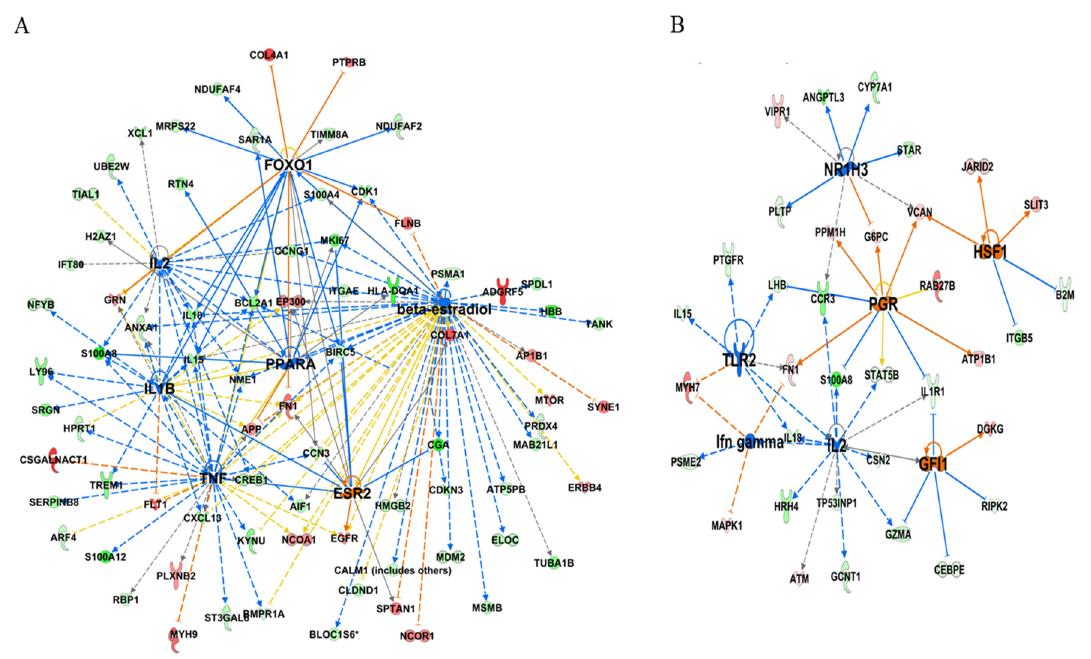
Figure 4. Networks generated for identified upstream regulators of DEGs in porcine endometrium on ( A ) Day 6 of pregnancy or ( B ) Day 6 after SP infusion. Red and green colors depict an increase or decrease, respectively, in the expression of a gene. The color intensity of nodes indicates a fold change increase or decrease associated with a particular DEG.